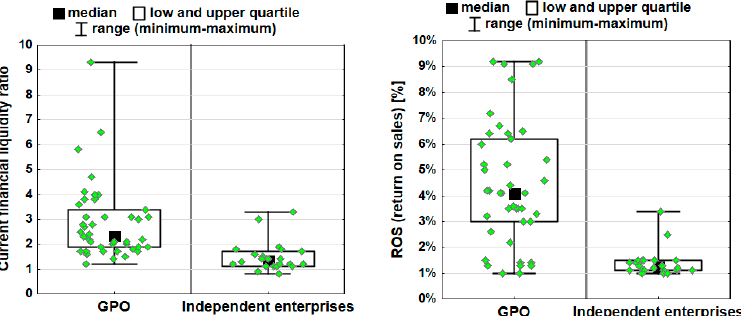
Figure 2. Positional statistics for financial liquidity and profitability in the compared groups. Source: author’s calculations and studies.